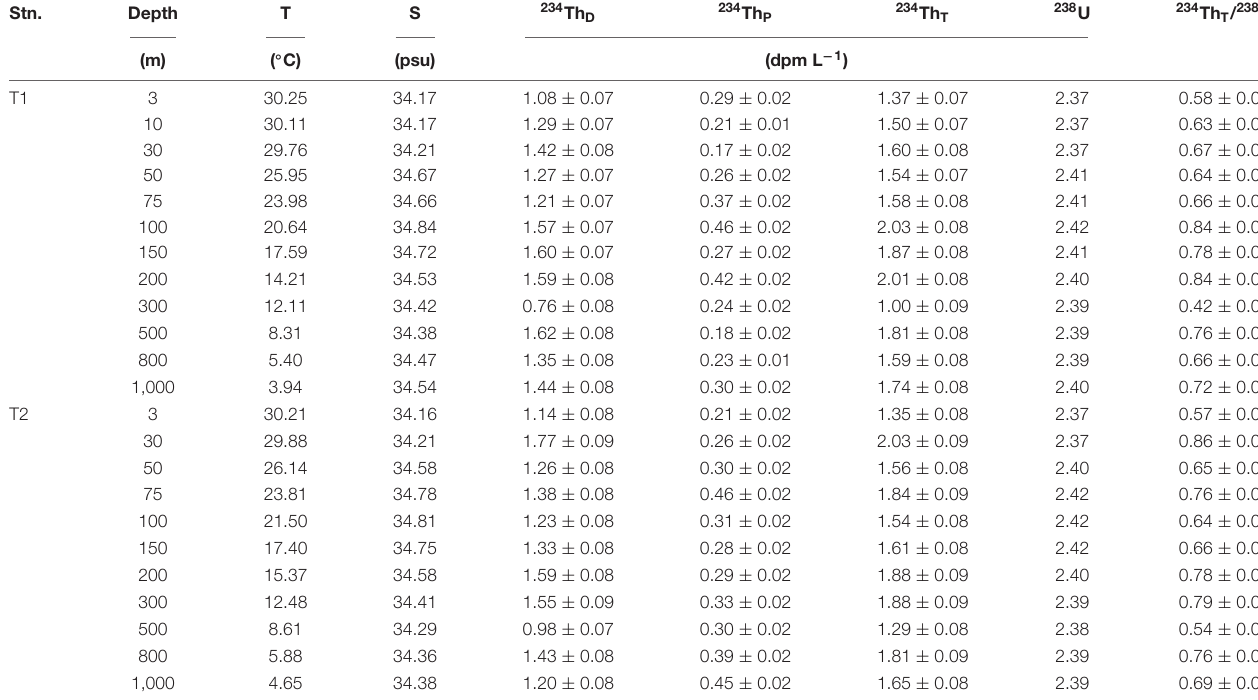
TABLE 1 | Temperature, salinity, the content of total particulate matter (TPM), the concentration of particulate organic carbon (POC), activity concentrations of dissolved 234 Th ( 234 Th D ), particulate 234 Th ( 234 Th P ), total 234 Th ( 234 Th T ), and 238 U, and the activity ratios of 234 Th T to 238 U during the Lagrangian observation from station T1 to station T2.